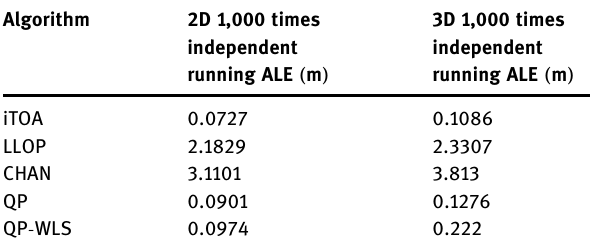
Table 4: Errors of 1,000 independent runs of each algorithm Algorithm